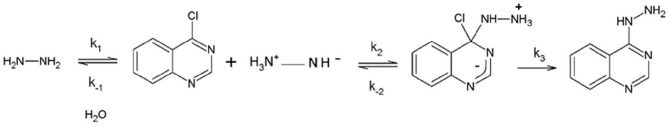
Proposed reaction mechanism for the reaction between 4-chloroquinazoline and hydrazine.